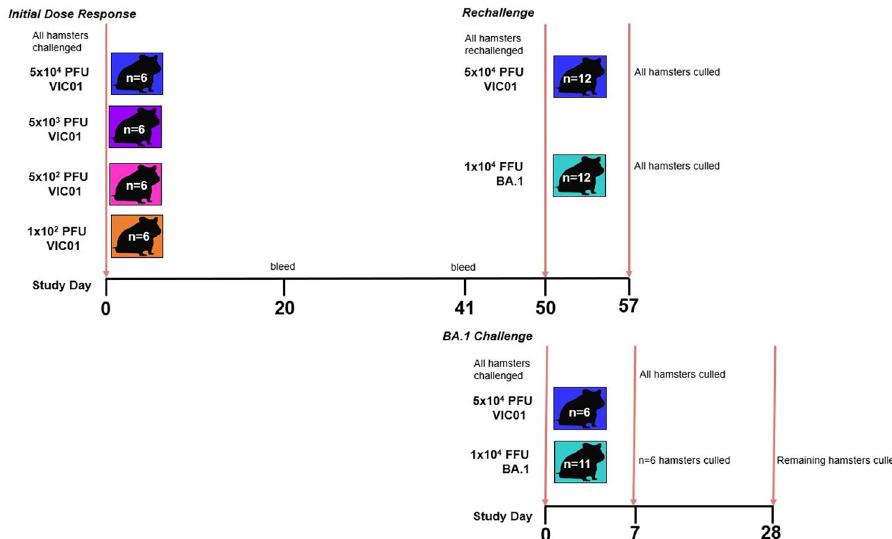
Fig 1. Study Design. The study was split into three individual sections. Initial Dose Response: Hamsters (n = 6 per group with an equal male/female split) were infected intranasally with VIC01 at four different target doses: 5E+04, 5E +03, 5E+02 and 1E+02 PFU. Blood was collected from infected hamsters at baseline (day 0), 20- and 41-days post infection to assess humoral responses. Rechallenge: At 50 days following the initial VIC01 challenge, a rechallenge with either VIC01 or BA.1 was performed on 3 animals from each VIC01 convalescent group. This equalled a n = 12 in each rechallenge group with an equal male/female split. BA.1 Infection: Two na ï ve control groups were included in this study with the purpose of being run alongside the rechallenge; n = 6 hamsters were infected with VIC01 (equal male/female split) and n = 11 (3 male/8 female) hamsters were infected with BA.1. All animals were culled 7 days later, except for n = 5 (all female) in the BA.1 control group which were culled at 28 days post infection. The throats of all hamsters were swabbed to monitor viral shedding post-infection and rechallenge. At necropsy animals underwent terminal exanguination bled. Nasal cavity and lungs were collected for pathological examination. In addition, lung was collected to assess viral burden and spleen was collected to assess cellular immune responses.